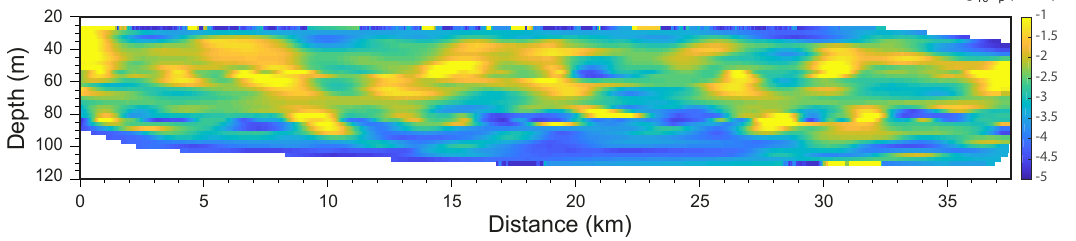
Figure 3. k ρ (x,z) map obtained along the seismic profile indicated in Fig. 1, following the procedure explained in the text. White colored areas correspond to poorly sampled areas, with too few data to properly calculate k